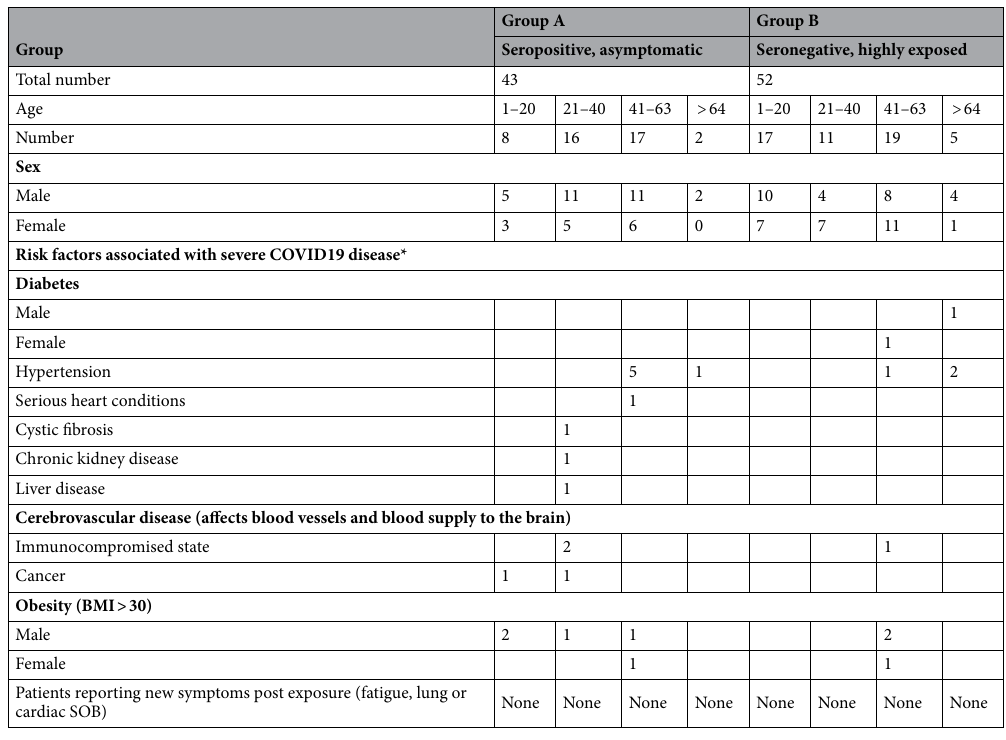
Table 1. Demographic and clinical characteristics of asymptomatic SARS-CoV-2 seropositive and highly exposed seronegative individuals test (Chi-Square 7.66, p-value